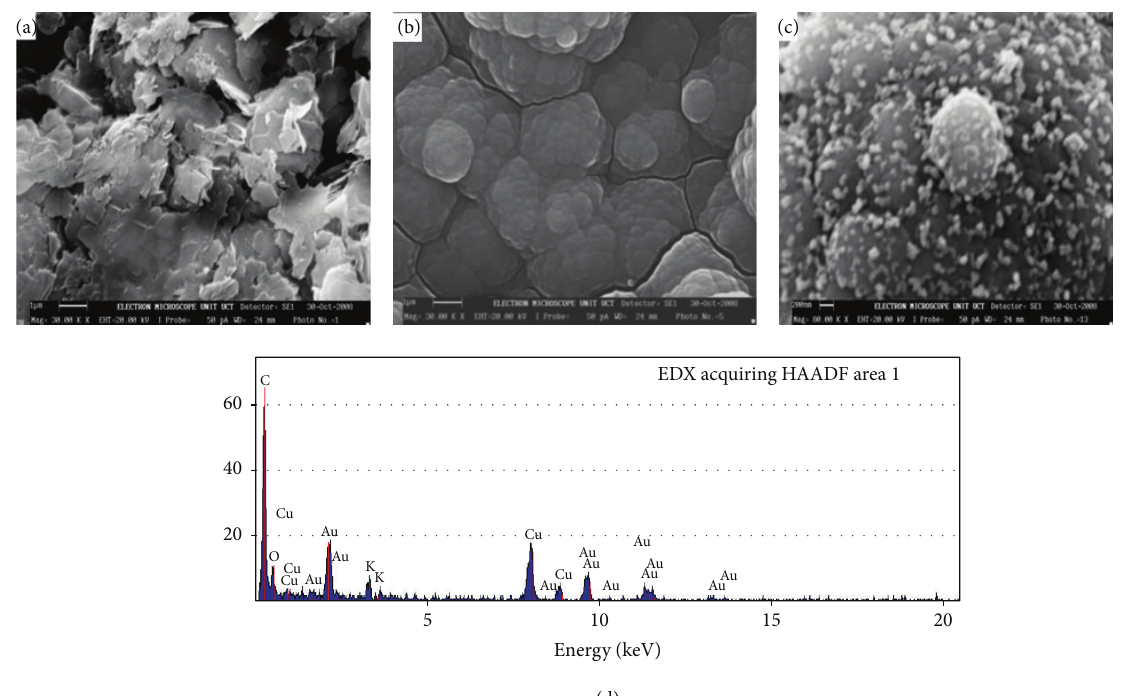
Figure 1: SEM of Ppy || GCE (a), OvOxPpy || GCE (b), and GNP | OxPpy || GCE (c), respectively, at 30 000 Mag (scale = 1 𝜇 m) with the EDX spectrum